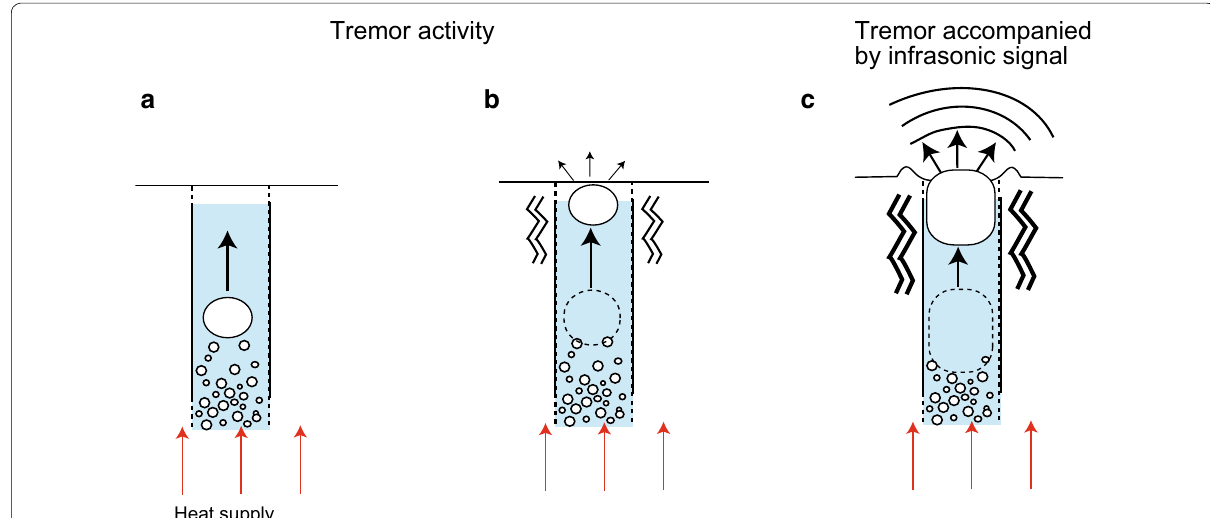
Fig. 15 Schematic diagram of the mechanism that generated the volcanic tremor and the infrasonic signal. a and b The volcanic tremor during acoustic quiet period, c that accompanied by infrasonic